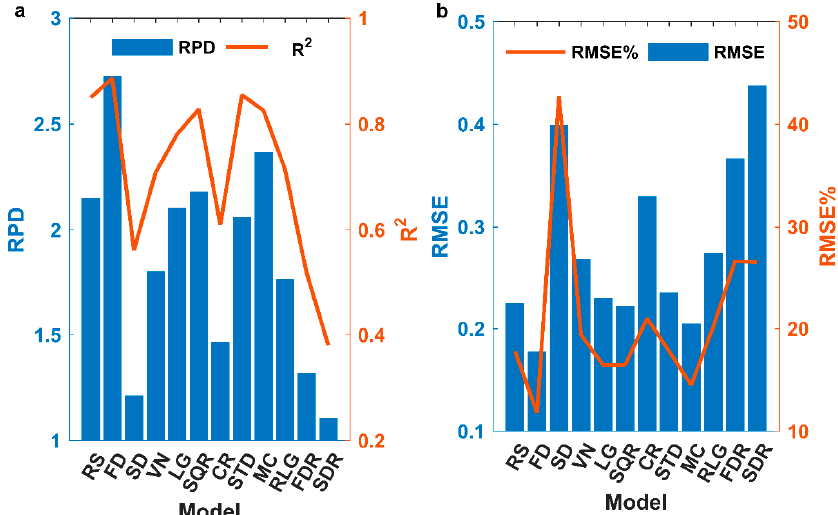
Figure 8. Model estimate results. Model estimation results of the SPA–Partial Least Squares Regression (PLSR) based on different spectral forms. ( a ) Represents the ratio of performance to deviation (RPD) and R 2 of the model estimation result, and ( b ) represents the root mean square error (RMSE) and RMSE% of the model estimation result.